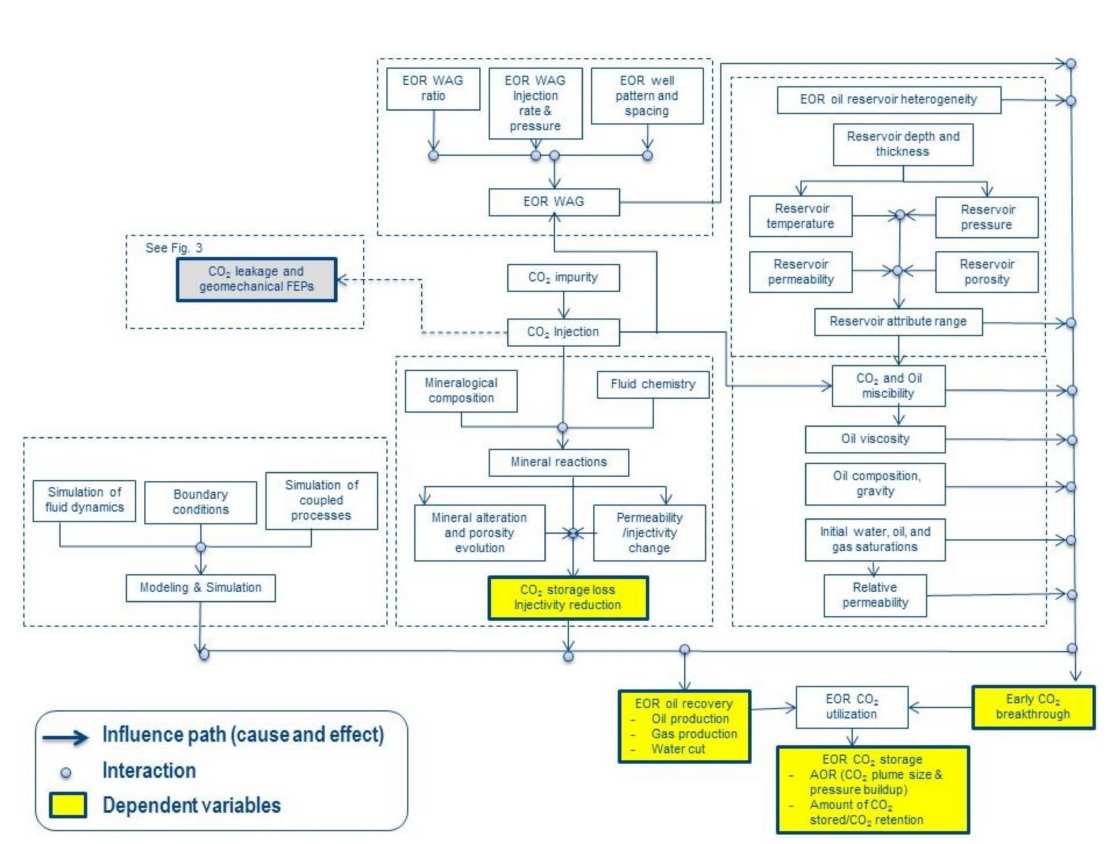
Figure 2. Process influence diagram (PID) for CO 2 storage and CO 2 -EOR risks/FEP in Southwest Regional Partnership (SWP) project. An arrow shows the influence path and each connection point is represented by a filled